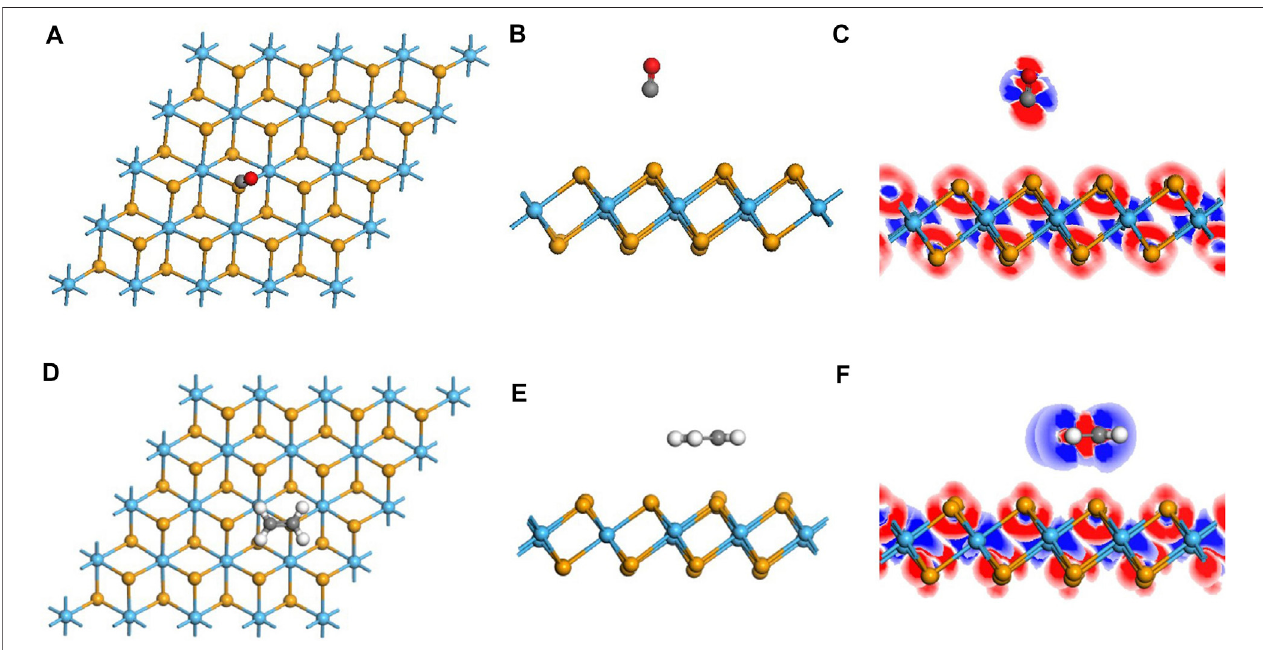
FIGURE 3 | Geometric and electronic structures of the adsorption system ofCO and C 2 H 4 on the intrinsic monolayer. (A – C) Adsorption system of CO and related DCD. (D – F) Adsorption system of C 2 H 4 and related DCD.